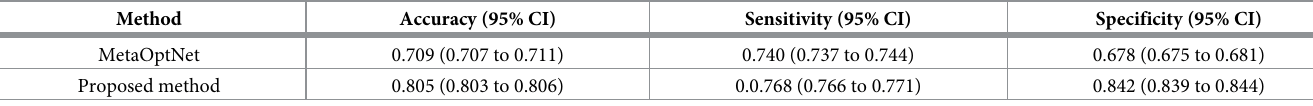
Table 2. The classification performance of MetaOptNet and proposed method in strabismus